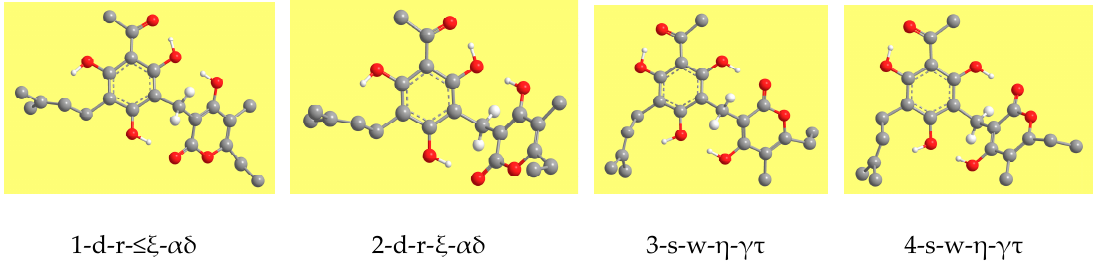
Figure 2. The four mutual orientations of the two rings in the arzanol molecule. The H atoms attached to C atoms are hidden to better highlight the geometry of the molecular skeleton. Only the H atoms attached to C9 are shown because they are functional to highlighting the mutual orientations of the two rings and the orientation of the methylene bridge.